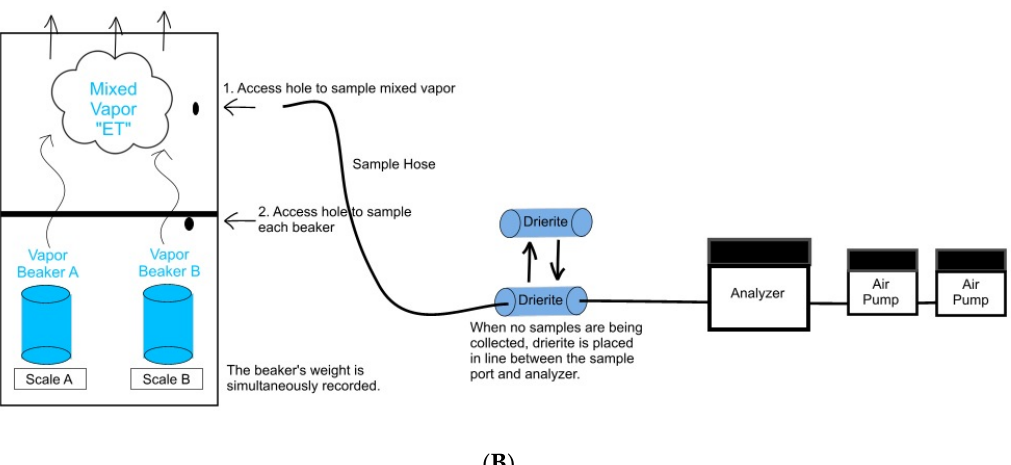
Figure 1. ( A ) Photo of lab experiment. ( B ) Illustration of lab experimentation.